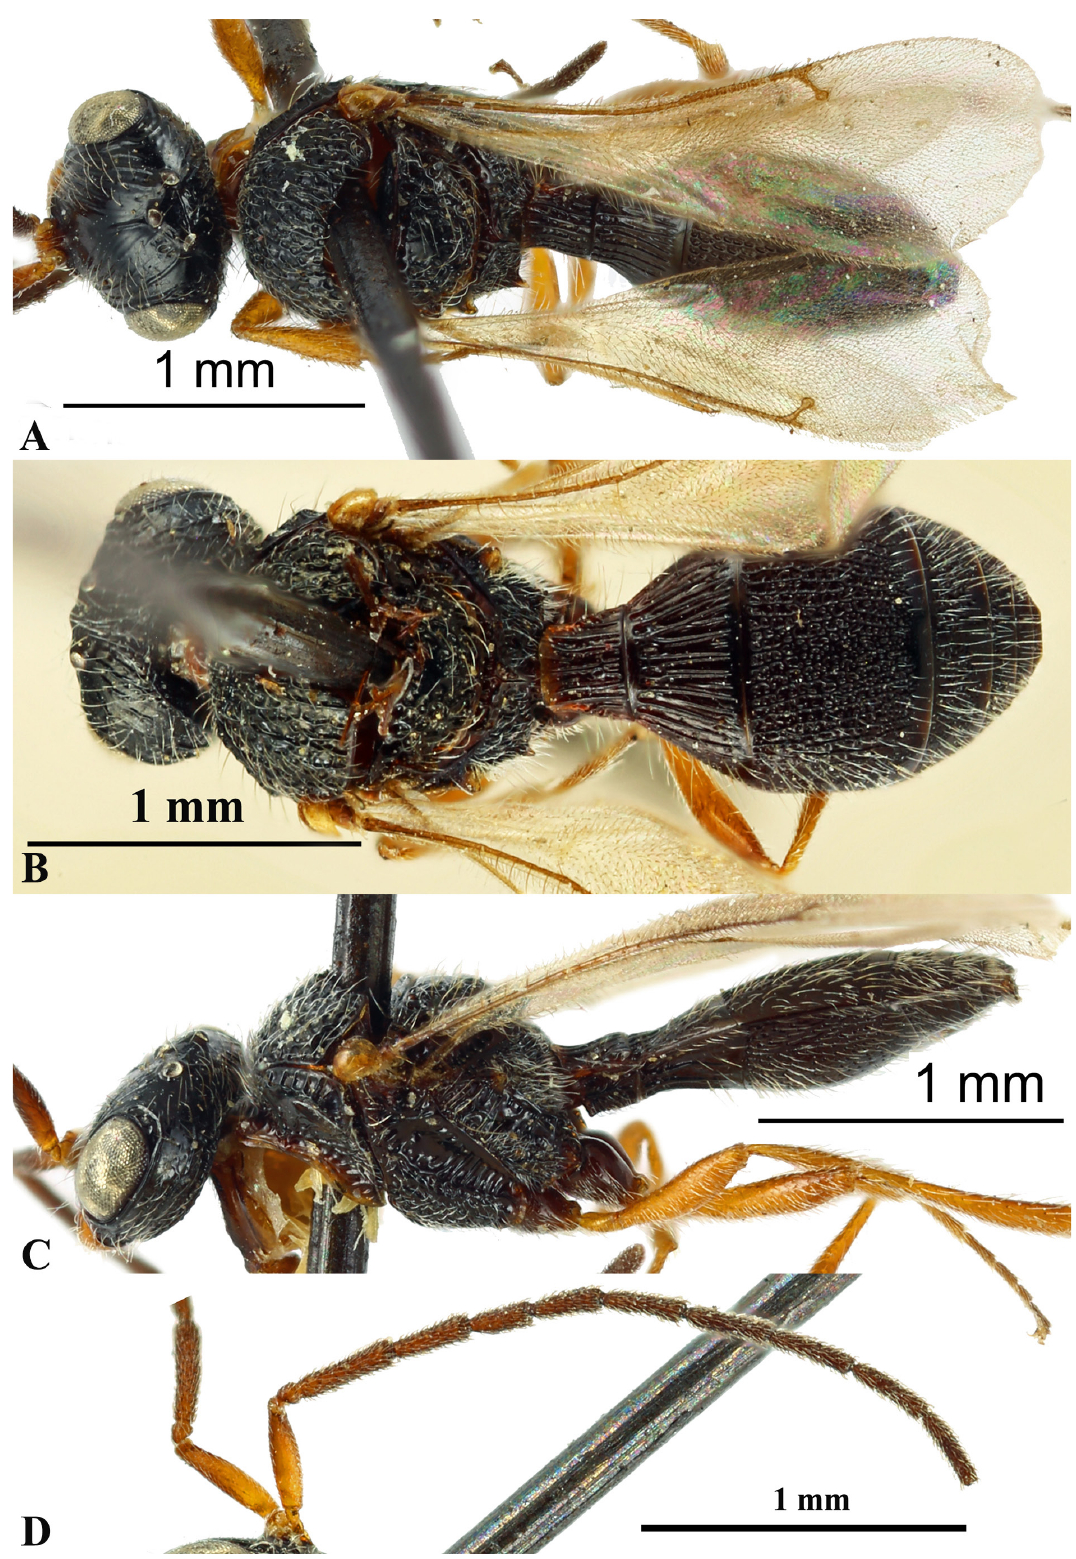
Fig. 13. Odontoscelio laticephalus (Risbec, 1950). Syntypes, ♂♂ (A, C: MNHN EY25673; B: MNHN EY25672; D: MNHN EY25674). A . Habitus (dorsal view). B . Habitus (dorsal view). C . Habitus (lateral view). D . Antenna. Photos: Agnièle Touret-Alby © ,